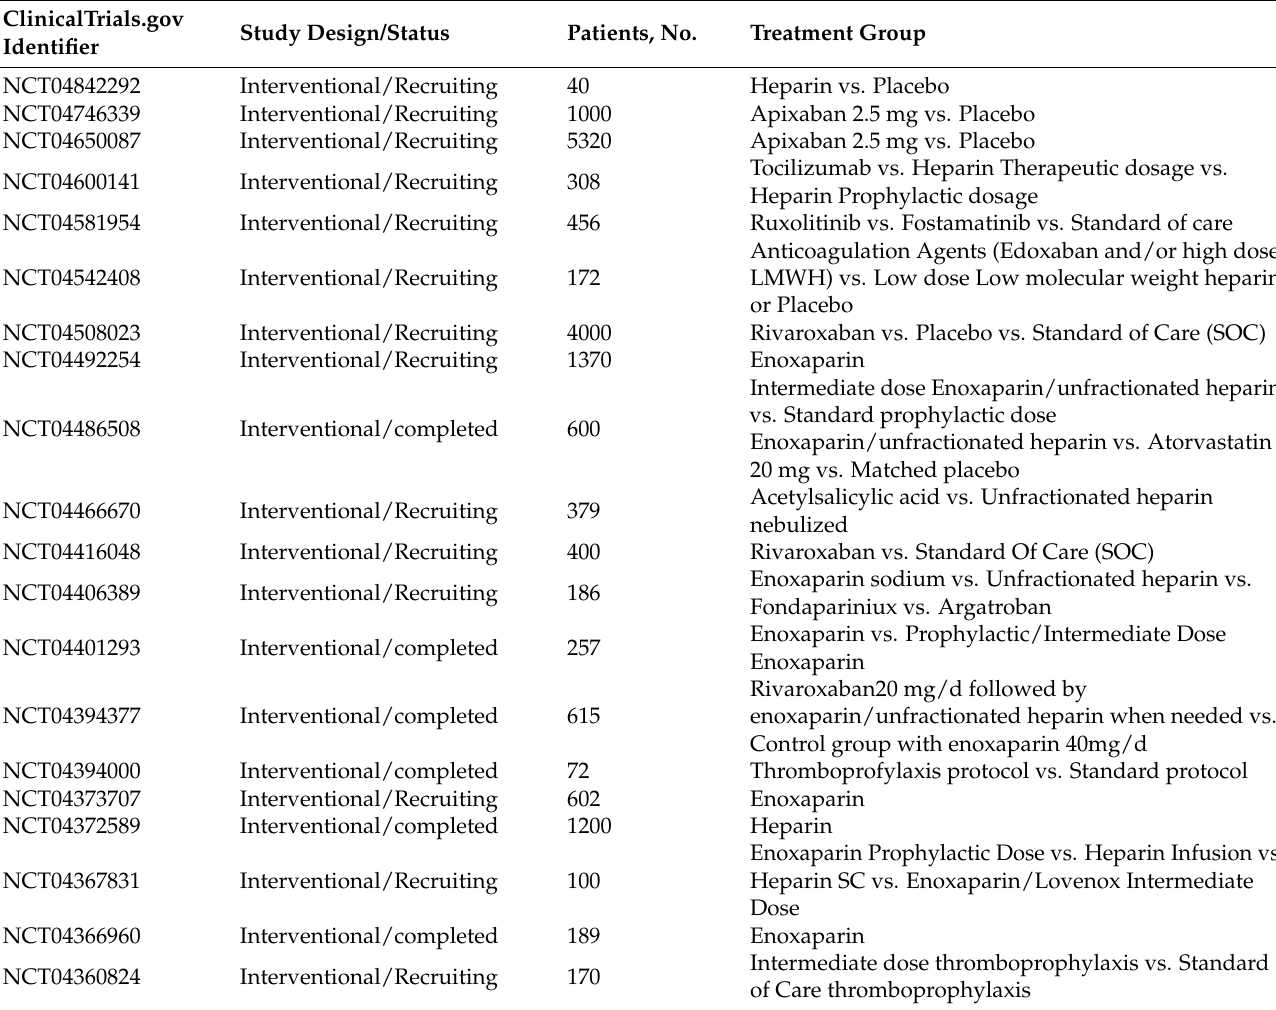
Table 1. Ongoing trials focusing on interventions for the prevention and treatment of VTE in COVID-19 patients up to 28 August